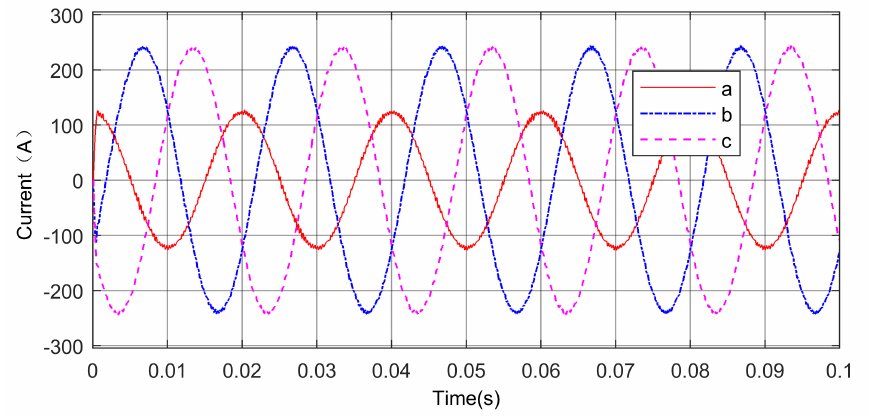
Figure 9. Output three-phase current diagram under case